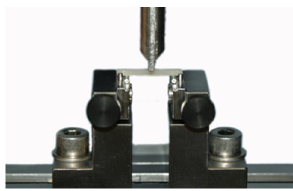
Figure 2. Three ‐ point flexural strength test.